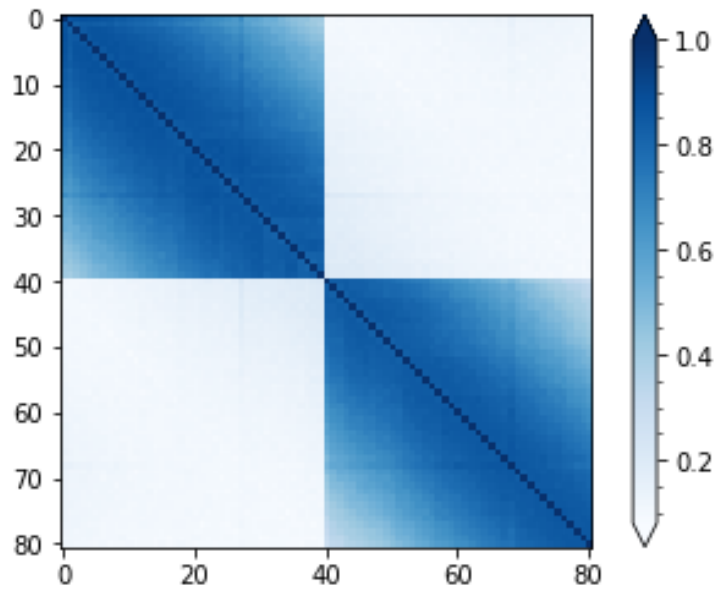
Figure 2. Kernel matrix estimated on the IBM Yorktown quantum computer.